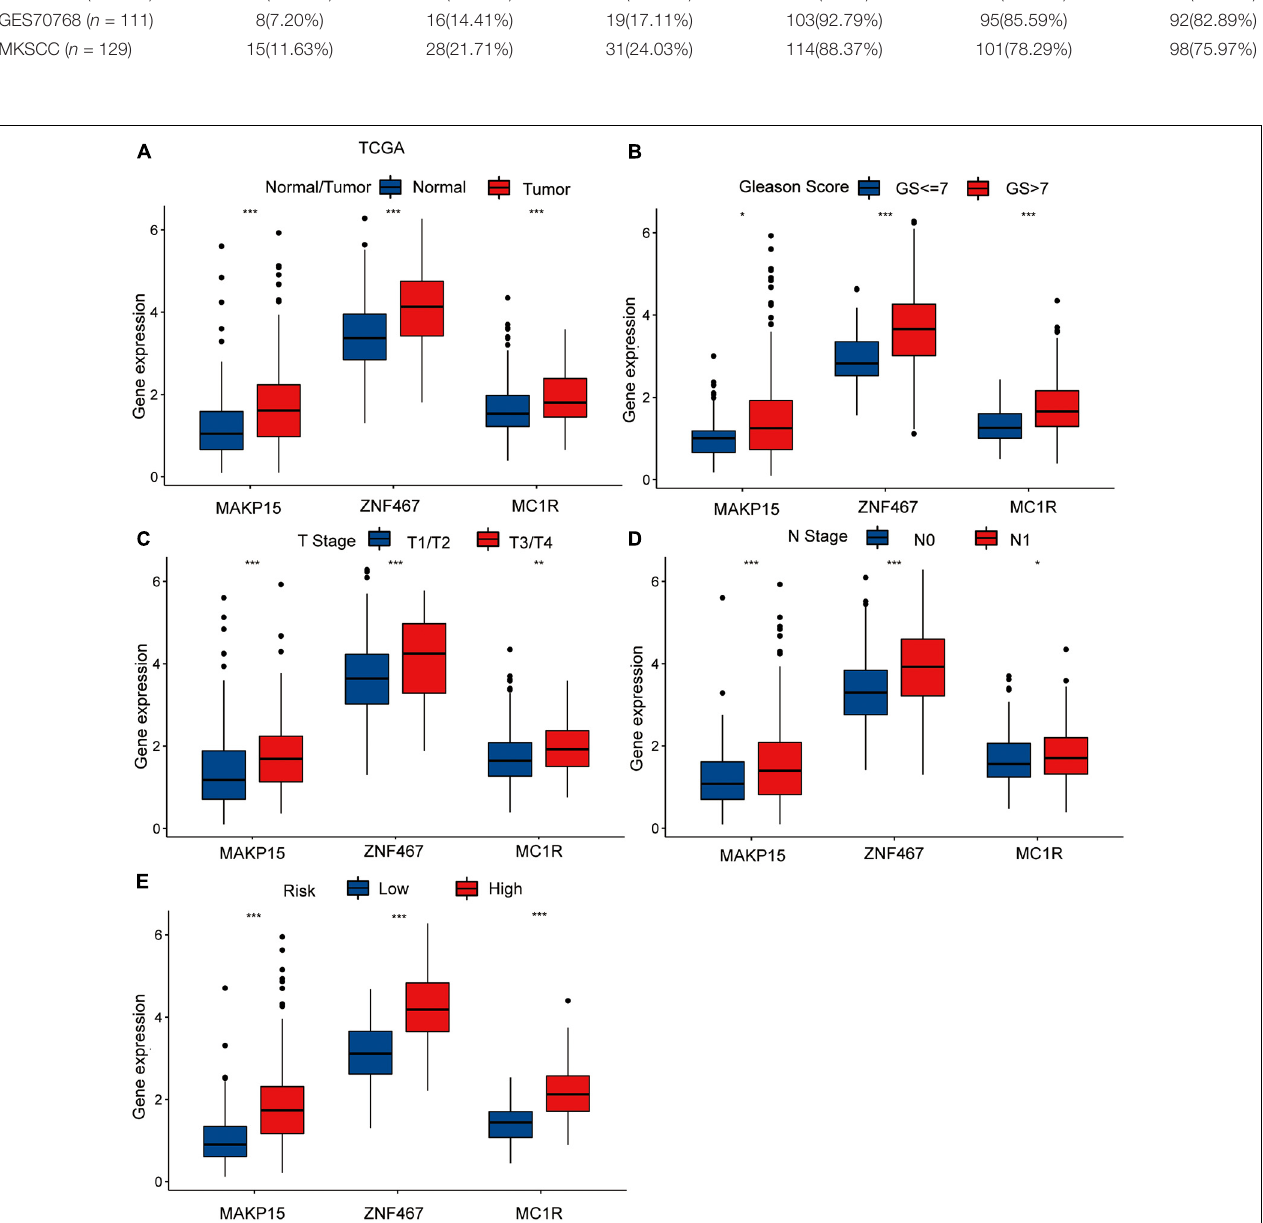
FIGURE 3 | The differential analysis of three risk model genes between PRAD tissue and normal prostate tissue in TCGA (A) . The differential analysis of three risk model genes between different Primary Tumor T stage samples (B) , different Lymph Nodes N stage samples (C) , different Gleason score PRAD samples (D), and different risk samples (E) in TCGA cohort. The P values are labeled above each boxplot with asterisks (ns: represents no significance, * P < 0.05, ** P < 0.01, *** P < 0.001).